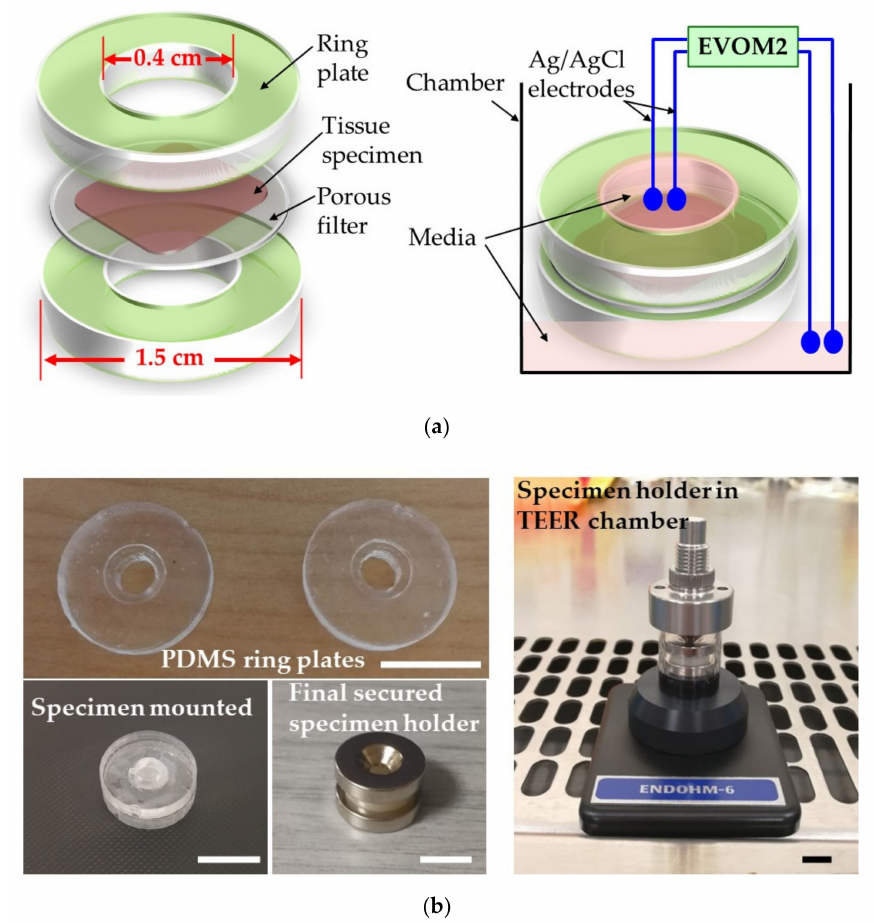
Figure 2. Design concept and experimental setup of the “sandwich ring”: ( a ) The drawing on the left side is a schematic representation of an exploded view of the “sandwich ring”, clearly illustrating how the tissue is clamped in-between two PDMS rings with a central hole smaller than the size of the specimen. For simplicity, the central grooves of the rings are not indicated in the drawing. The drawing on the right side shows in a simplified manner the insertion and usage of the “sandwich ring” in the Endohm-6 TEER chamber. ( b ) Images of the as-fabricated PDMS rings and the experimental setup for specimen loading and TEER measurement. The disc-shaped specimen is mounted in the central groove of the rings and secured by a pair of ring magnets. This secured specimen holder is then placed in an Endohm-6 TEER chamber with one pair of electrodes at the bottom and the other at the cap. The scale bars in all photos represent 1